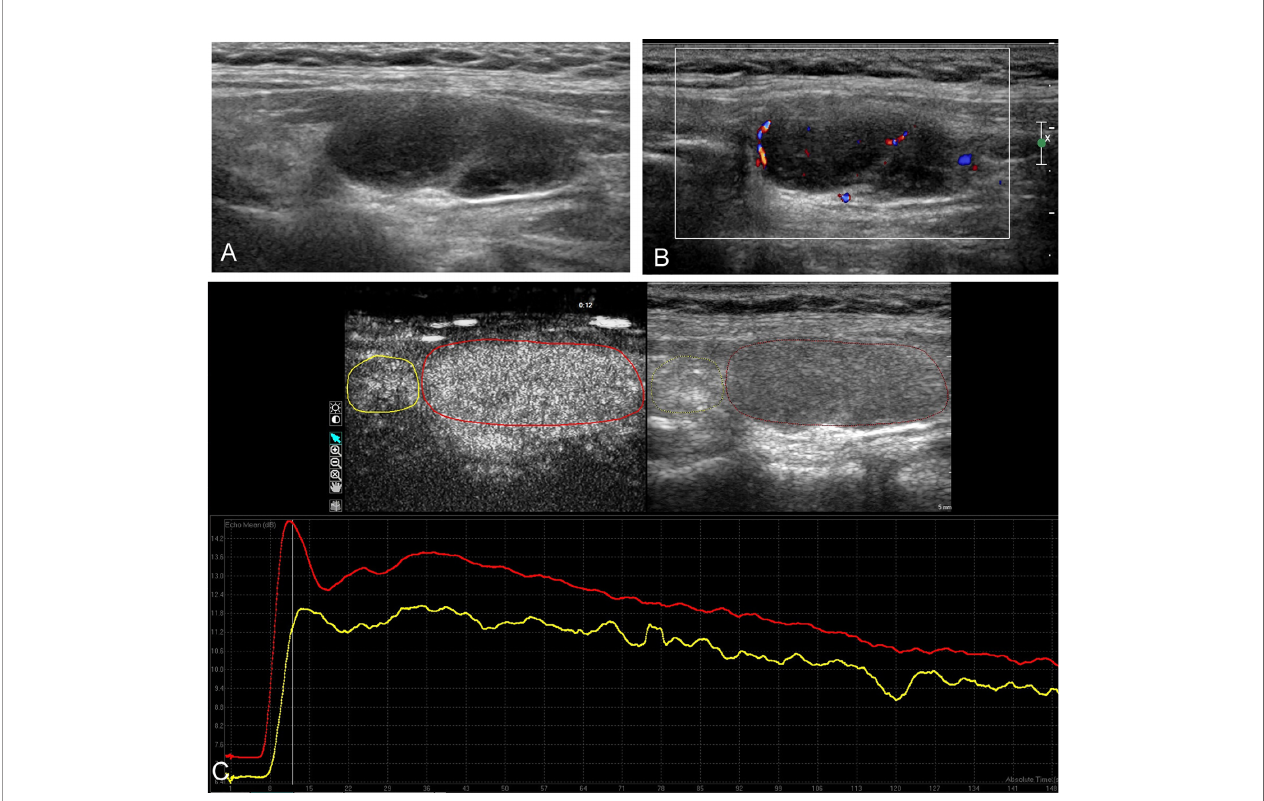
FIGURE 2 | Conventional ultrasound and contrast-enhanced ultrasound images of the nodular Hashimoto ’ s thyroiditis in the left thyroid lobe of a 26-year-old female with diffuse Hashimoto ’ s thyroiditis background. (A) B-mode ultrasound image of a maximum diameter of 33 mm nodule displayed hypoechogenicity with well- de fi ned margin. (B) Color Doppler image revealing the mainly peripheral distributed vascularity of the nodule. (C) Contrast-enhanced ultrasound image revealing the homogeneous hyper-enhancement of the lesion (red circle), with respect to the surrounding parenchyma (yellow circle); time – intensity curves of the lesion (red curve) and parenchyma (yellow curve) were generated to calculate the corresponding quantitative